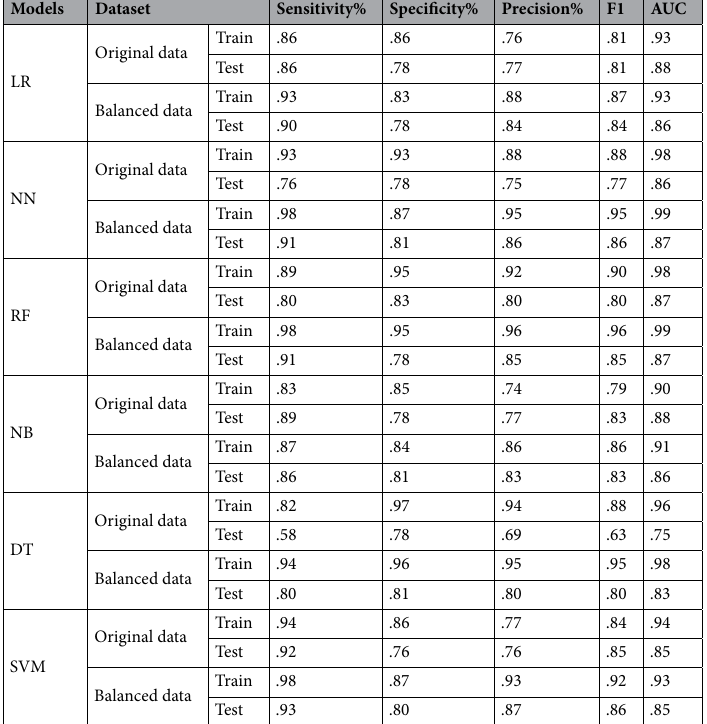
Table 2. Model performance to predict metastasis in ML approaches using 5-fold cross validation in original data and Balance data with oversampling method. Abrivation: Naive Bayes (NB), Random Forest (RF), Support Vector Machine (SVM), Neural Network (NN), Desicion Tree (RT) and Logistic Regression